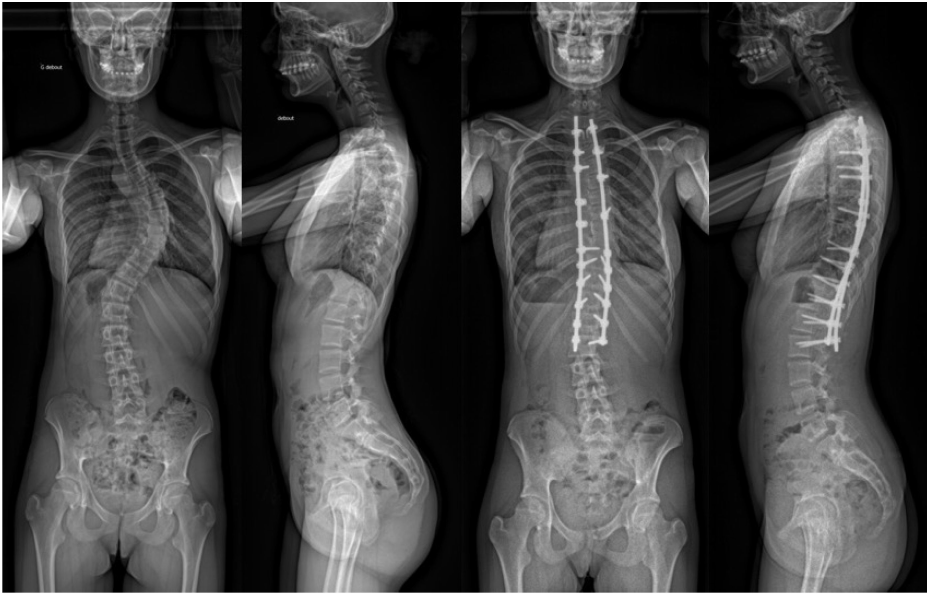
Figure 1. Pre- and post-operative full-spine coronal and sagittal X-rays illustrating a typical long construct for posterior fusion to correct a